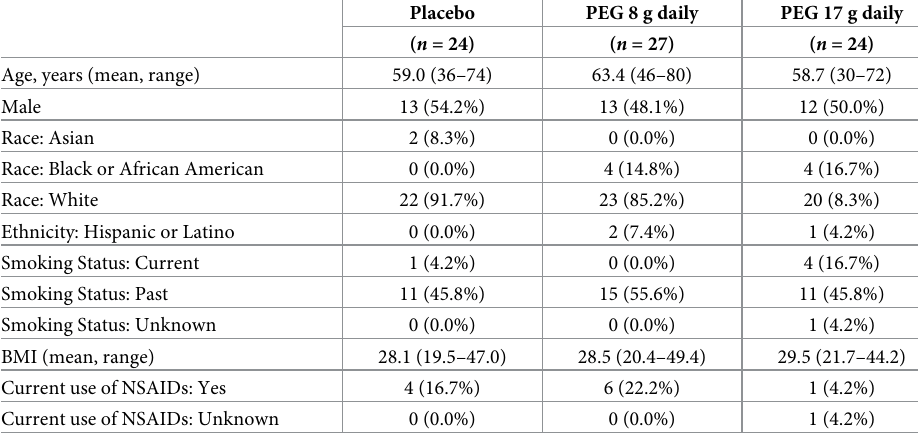
Table 1. Demographics of study